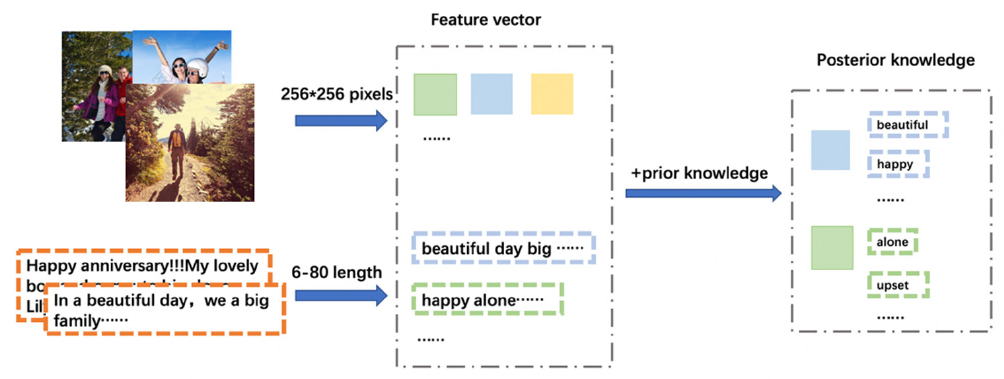
Figure 5. The processing of the input data.